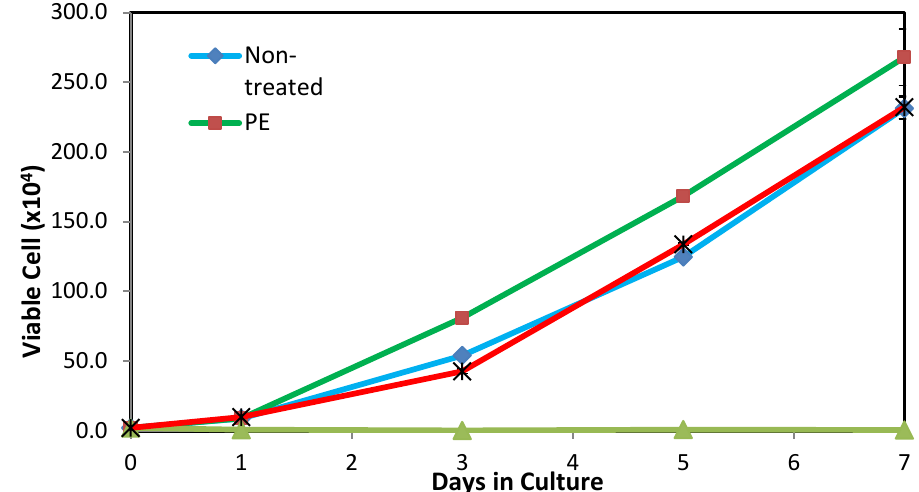
Figure 5. The proliferation curve of viable L929 cell. The experiments were conducted in triplicate independently (n = 3), and the data are expressed as the means ± standard deviation (SD) with p < 0.05. In addition to that, the cells will not be able to proliferate at all due to the surface chemistry of the substance even over a period of seven days. On the other hand, the cells treated with PE (negative control) exhibited e ff ective cell growth promotion similar to results seen in the clonogenic assay. The